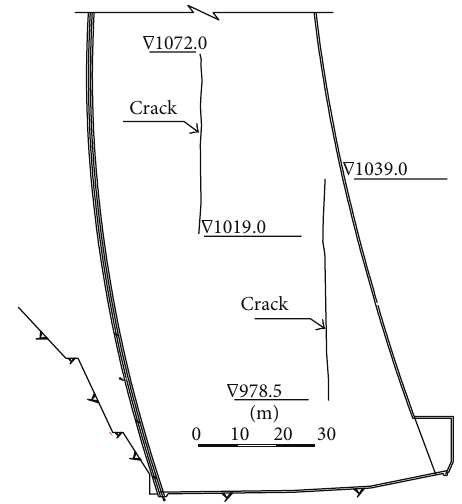
Figure 9: Distribution of cracks in typical dam section.